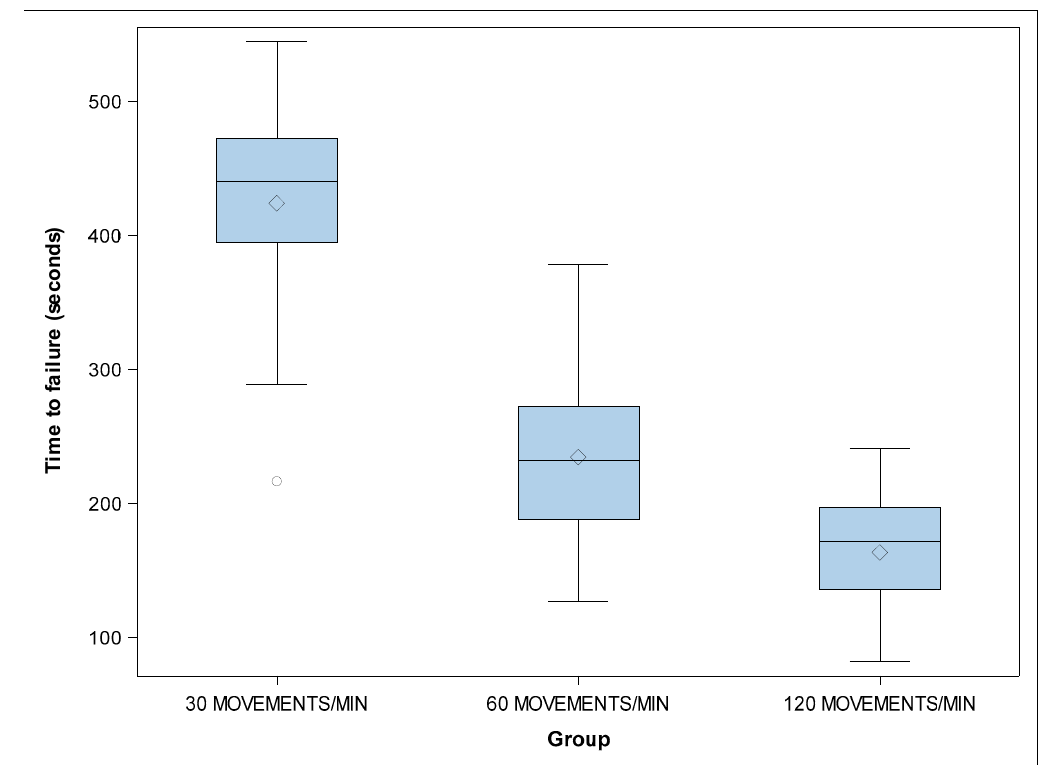
Figure 4. Boxplots of the time to failure of the experimental groups. The horizontal line in each box represents the median value.